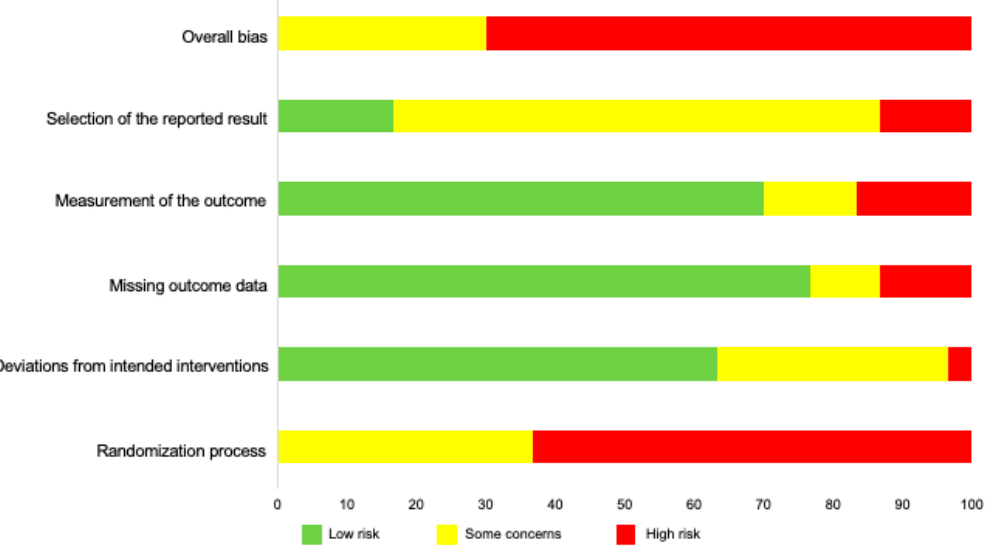
Figure 6. Risk of bias across all mouse studies, including brain, liver, cardiovascular, and pulmonary. This figure displays the relative percentages of intention-to-treat data of assessed risk of bias in all mouse studies. The overall bias was determined using five categories: Selection of the reported result, measurement of the reported outcome, missing outcome data, deviations from intended interventions, and randomization process. Risk was determined as “low risk,” “some concerns,” or “high risk,” based on the Cochrane RoB 2.0 tool algorithm. The data for this figure included 24 articles.